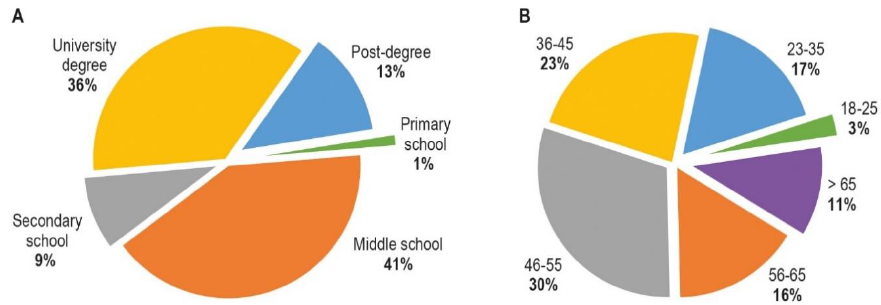
Figure 1. The demographic characteristic of all respondents ( n = 497) education level: ( A ) and age ( B ).